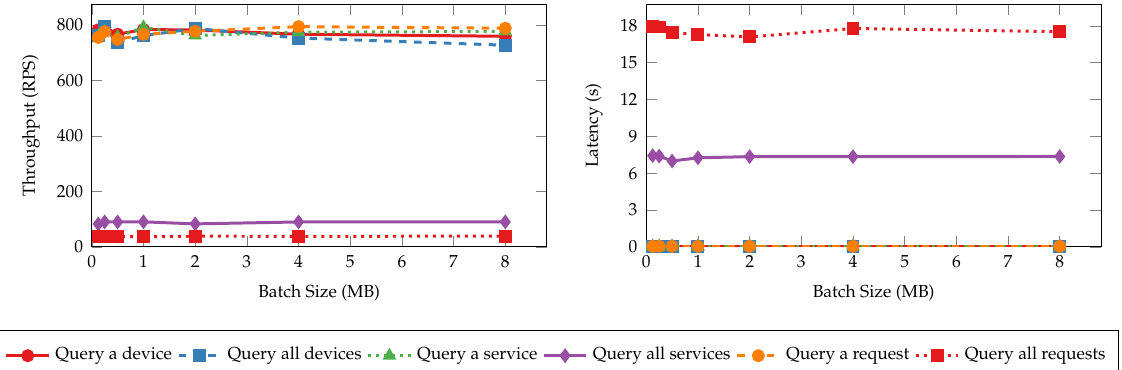
Figure 9. Throughput and latency of read operations with varying batch sizes.